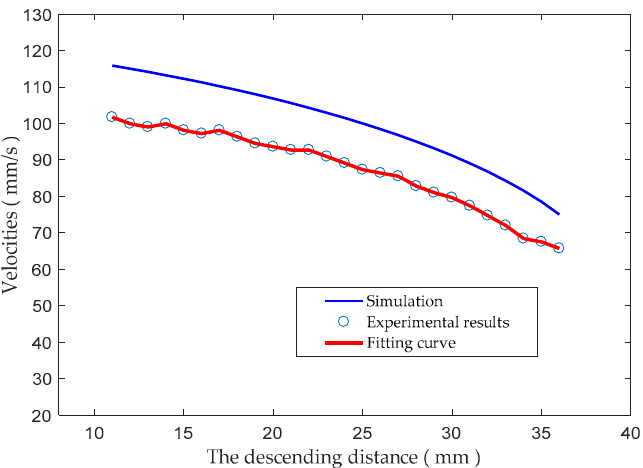
Figure 12. The sliding velocities at different descent distances.